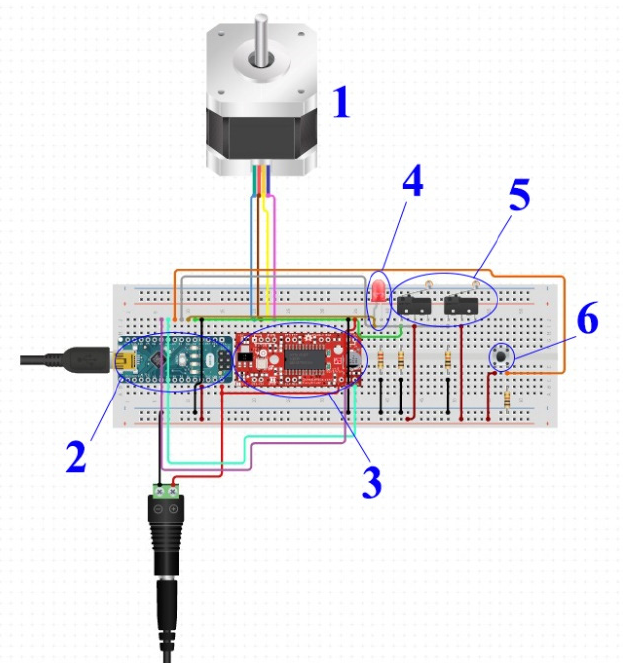
Figure 6. Electrical diagram: 1—17HS4401 motor, 2—Arduino Nano, 3—a4988 driver, 4—LED, 5—switch, 6—Button.